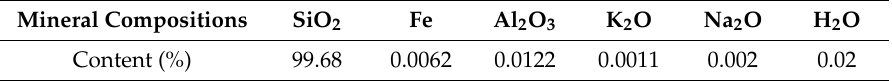
Table 3. Chemical compositions of quartz sand.